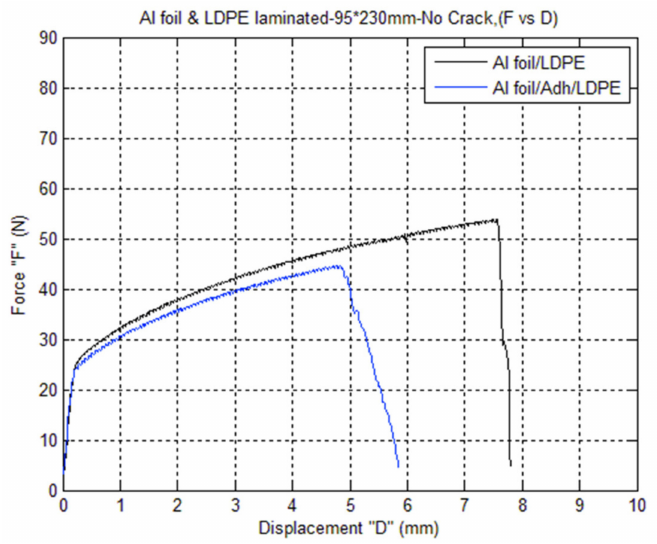
Figure 19. Comparison of experimental results between Al foil/LDPE and